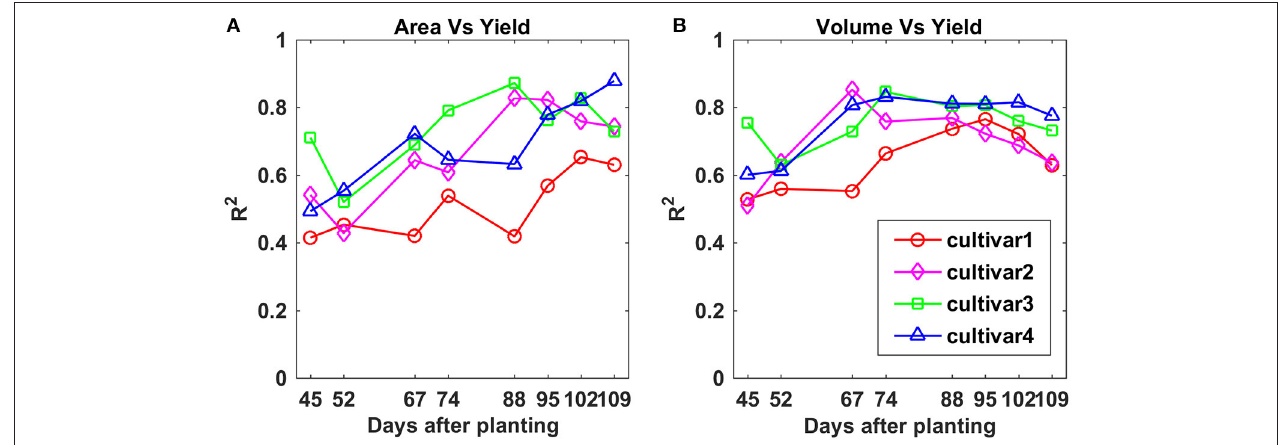
FIGURE 11 | Correlation analysis results between (A) projected canopy area and yield, and (B) plant volume and yield by days after planting for each cultivar.